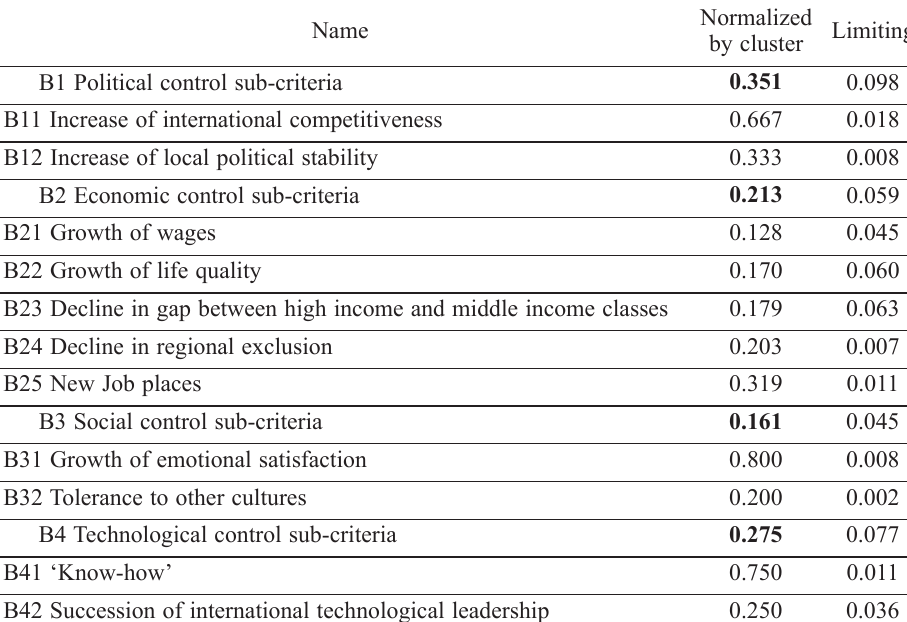
Table 4. Priorities of the elements in the benefit sub-network Name